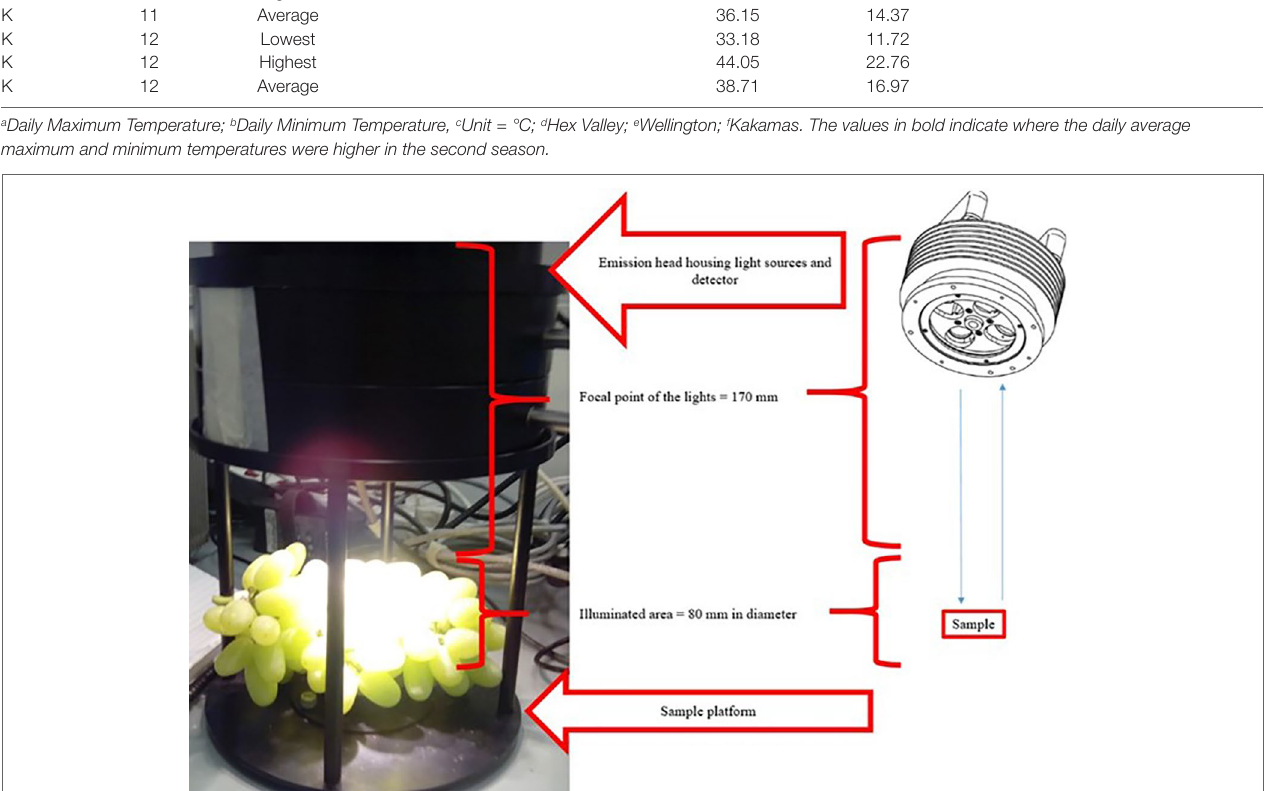
Frontiers in Plant Science |